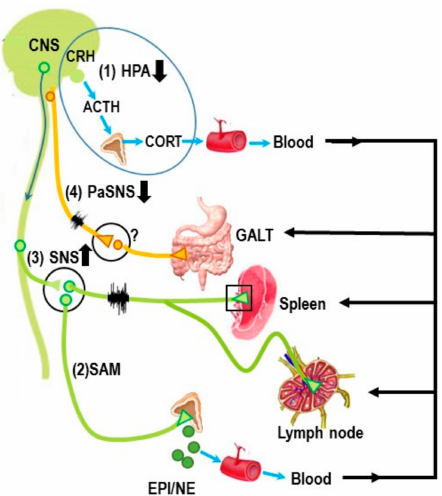
Figure 1. The major neuroendocrine and autonomic pathways that regulate secondary immune organs are illustrated. They include two neuroendocrine pathways, ( 1 ) the hypothalamic–pituitary–adrenal axis (HPA) and ( 2 ) the sympatho-adrenal medullary (SAM) axis, and two “hardwired” autonomic circuits, ( 3 ) the sympathetic nervous system (SNS) and ( 4 ) the parasympathetic nervous system (PaSNS). ( 1 ) The HPA axis is a feedback system whereby corticotropin-releasing hormone (CRH) is released from neurons in the hypothalamus that project their axons into the anterior pituitary. The release of CRH stimulates the secretion of adrenocorticotropic hormone (ACTH) into the circulation. ACTH stimulates the release of corticosterone (CORT) into the bloodstream. Circulating CORT has systemic effects including effects on secondary immune organs or tissues (Spleen, lymph nodes and gut-associated lymphoid tissue (GALT) are shown in the illustration). ( 2 ) In the SAM axis, preganglionic sympathetic neurons secrete acetylcholine in the adrenal medulla, which stimulates the release of catecholamines, predominantly epinephrine (EPI) and, to a much lesser extent, norepinephrine (NE), into the circulation, such as the HPA axis. Circulating NE/EPI can potentiate the actions of sympathetic nerves acting at adrenergic receptors in immune organs. ( 3 ) The SNS circuit to the spleen and LNs is a two-neuron chain (green neurons), with preganglionic cholinergic sympathetic neurons innervating postganglionic neurons whose nerve terminals end in the spleen and lymph nodes. The major neurotransmitter of postganglionic neurons is norepinephrine (NE). In secondary lymphoid organs, such as LNs and spleen, NE binds to adrenergic receptors expressed on immune cells, vasculature and connective tissue cells. Ligand binding to adrenergic receptors regulates the cellular responses of the immune cells that express these receptors. The predominant adrenergic receptor subtype expressed on spleen cells is the β 2 -adrenergic receptor. ( 4 ) The PaSNS is also a two-neuron chain (yellow neurons) of efferent nerves that supply the viscera, in particular the gut. Preganglionic neurons reside in the brainstem (medulla) and exit the central nervous system (CNS) as cranial nerves that end upon postganglionic neurons, most often embedded in the visceral organs they supply. Depicted here is the parasympathetic supply to gut-associated lymphoid tissue (GALT). There is no definitive evidence that the PaSNS innervates the spleen, but the vagus nerve clearly can influence immune responses in the spleen—most likely via the migration of vagally influenced immune cells in the gut that migrate to the spleen. The up or down arrows shown next to these regulatory pathways indicate the most common direction of change in the activity of that pathway in most of the prevalent immune-mediated inflammatory diseases, including rheumatoid